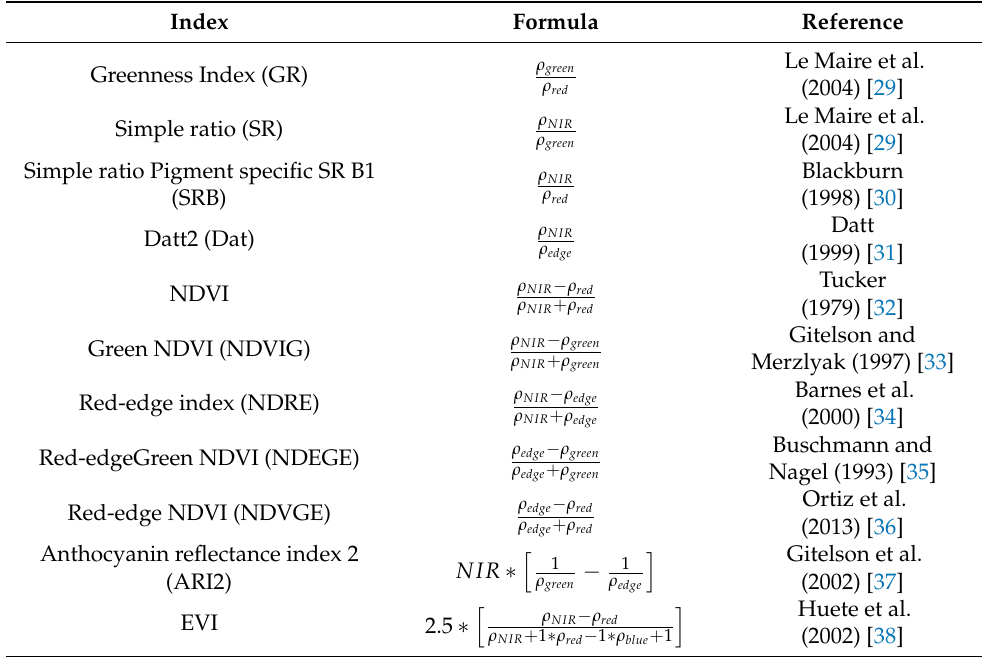
Table 2. Vegetation indices used in this study, ρ is the reflectance of band